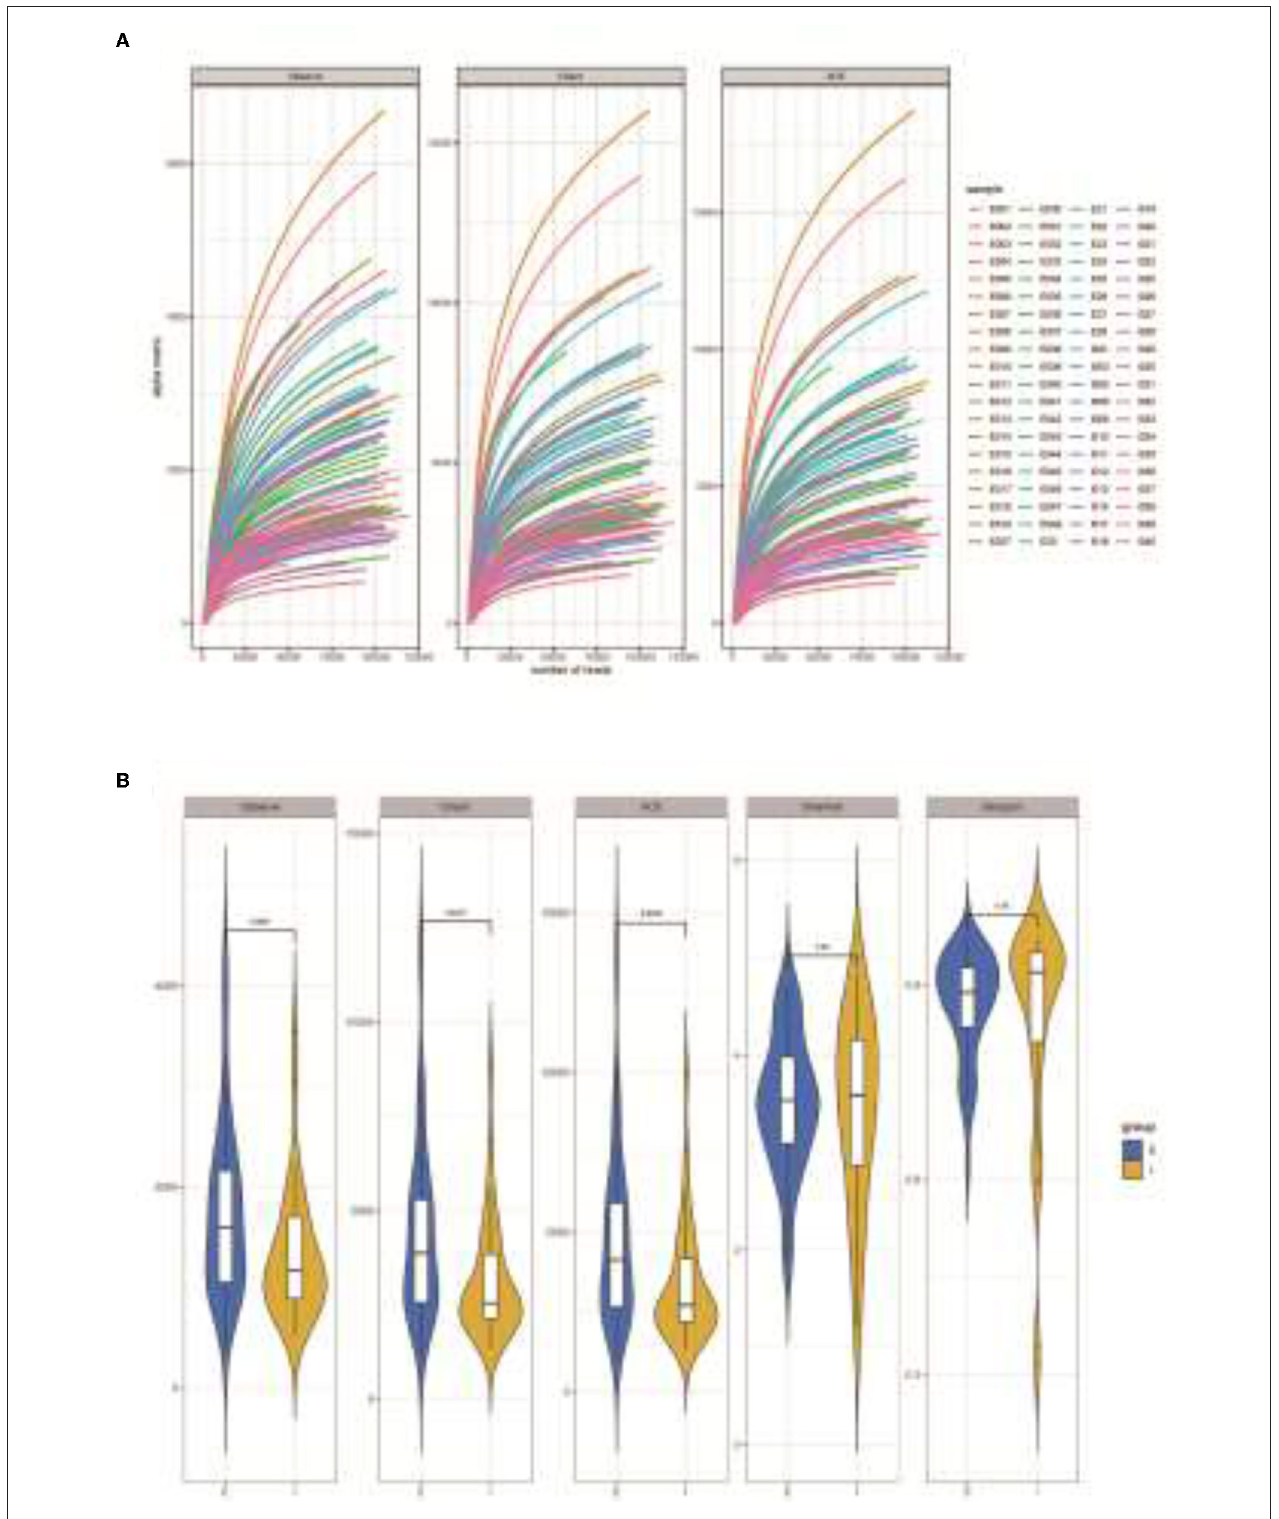
FIGURE 1 | Analysis of microbial diversity in sputum samples of COPD frequent exacerbators and infrequent exacerbators. (A) , 16S sequencing dilution curve results. (B) , QIIME software was used to calculate the Alpha diversity index of both sample groups. E represented COPD frequent exacerbators; I represented COPD infrequent exacerbators. COPD, chronic obstructive pulmonary